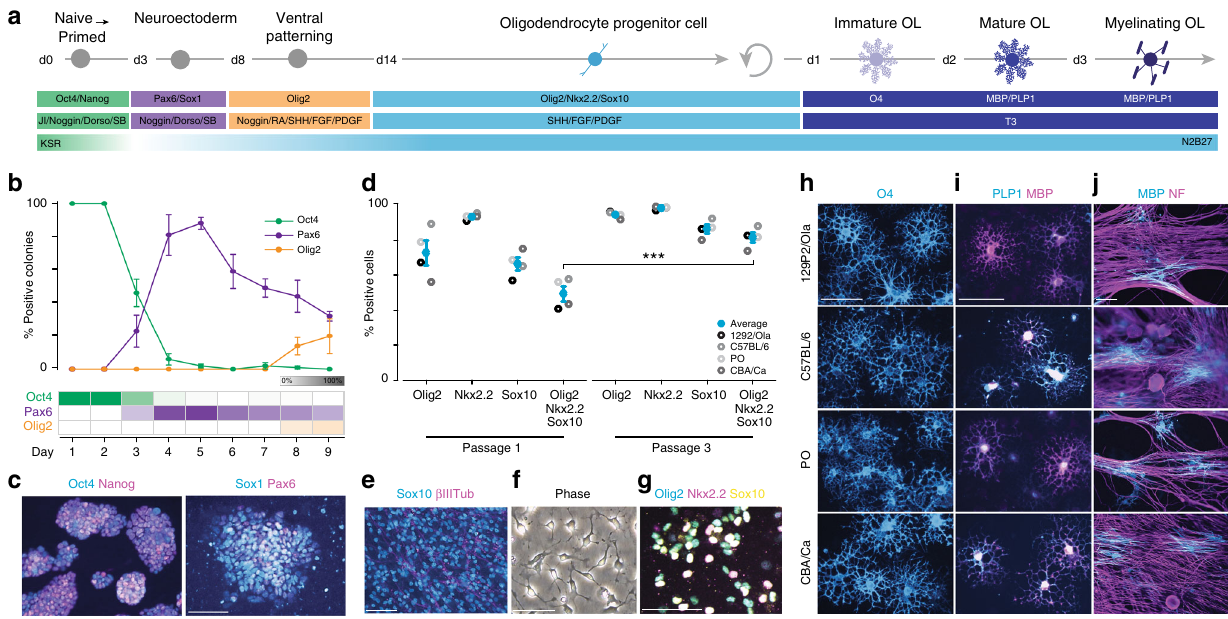
Fig. 1 Reproducible generation of OPCs and oligodendrocytes from mESCs. a Graphical overview of the differentiation time course for generating OPCs and stage-speci fi c oligodendrocytes from mESCs. b Quanti fi cation of immunocytochemistry for stage-speci fi c markers demarcating the transition from pluripotency (Oct4) to neuroectoderm (Pax6) to ventral neural tube (Olig2) over 9 days. n = 4 independent biological replicates (mESC lines) with >25 colonies scored per cell line. Data are represented as means ± SEM. c Representative immuno fl uorescent images of starting mESCs (Oct4 and Nanog) and day 5 neuroectoderm (Pax6 and Sox1). Scale bar, 50 µ m. d Quanti fi cation of OPC-de fi ning transcription factors Olig2, Nkx2.2, and Sox10 at passages 1 and 3 of the differentiation protocol. n = 4 independent mESC lines; >114,500 cells scored per cell line. Data are represented as means± SEM. *** P value <0.001; unpaired t test. e Immuno fl uorescent image of passage 1 cultures stained for Sox10, an OPC marker, and β III-Tubulin, a marker of neurons. Scale bar, 50 µ m. f Representative phase contrast image of mESC-derived OPCs exhibiting a canonical bipolar morphology. Scale bar, 50 µ m. g Immunostained image of passage 3 mESC-derived OPCs co-expressing Olig2, Nkx2.2, and Sox10, canonical OPC transcription factors. Scale bar, 50 µ m. h Cell surface immunostaining of the immature oligodendrocyte marker O4, after treatment with T3. Scale bar, 50 µ m. i Representative images of differentiated OPCs immunostained for mature oligodendrocyte markers MBP and PLP1, 72 h post treatment with T3. Scale bar, 50 µ m. j Representative images of OPC/DRG co-cultures stained for MBP and neuro fi lament (NF) at day 10. Scale bar, 50 µ m. Unless otherwise noted, images presented in Fig. 1 are derived from the CBA/Ca mESC line, and are representative of results obtained with C57BL/6, PO, and 129P2/Ola lines, which are shown separately in Supplementary Fig.